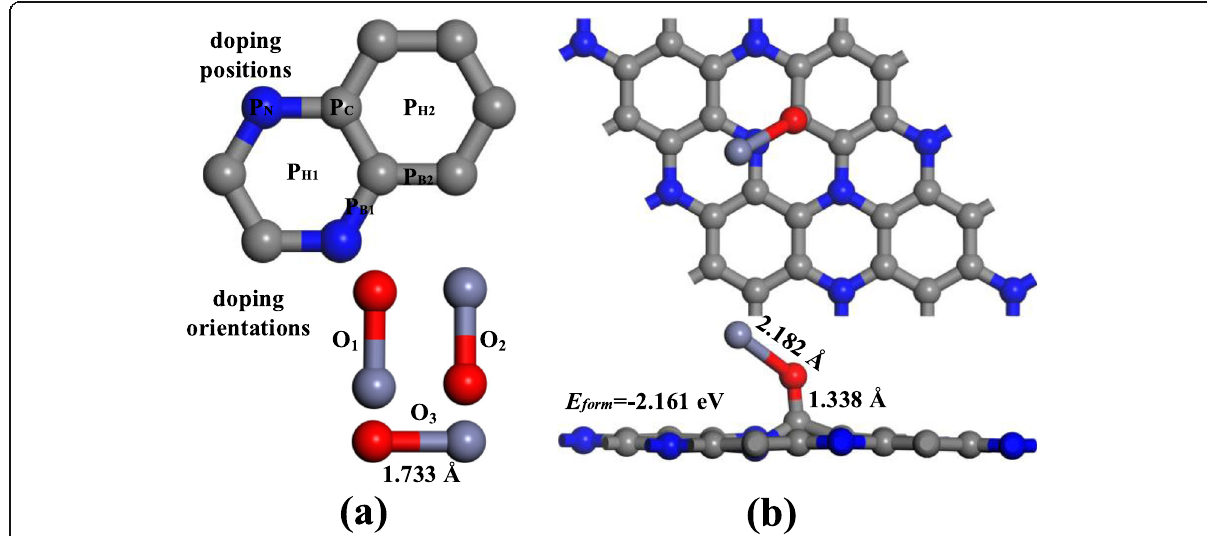
Fig. 2 a The approaching positions and orientations of ZnO molecule. b The most stable configuration of ZnO-C 3